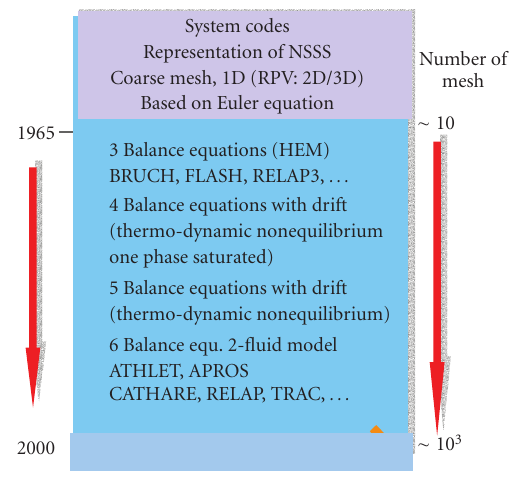
Figure 1: Code development activities in more than three